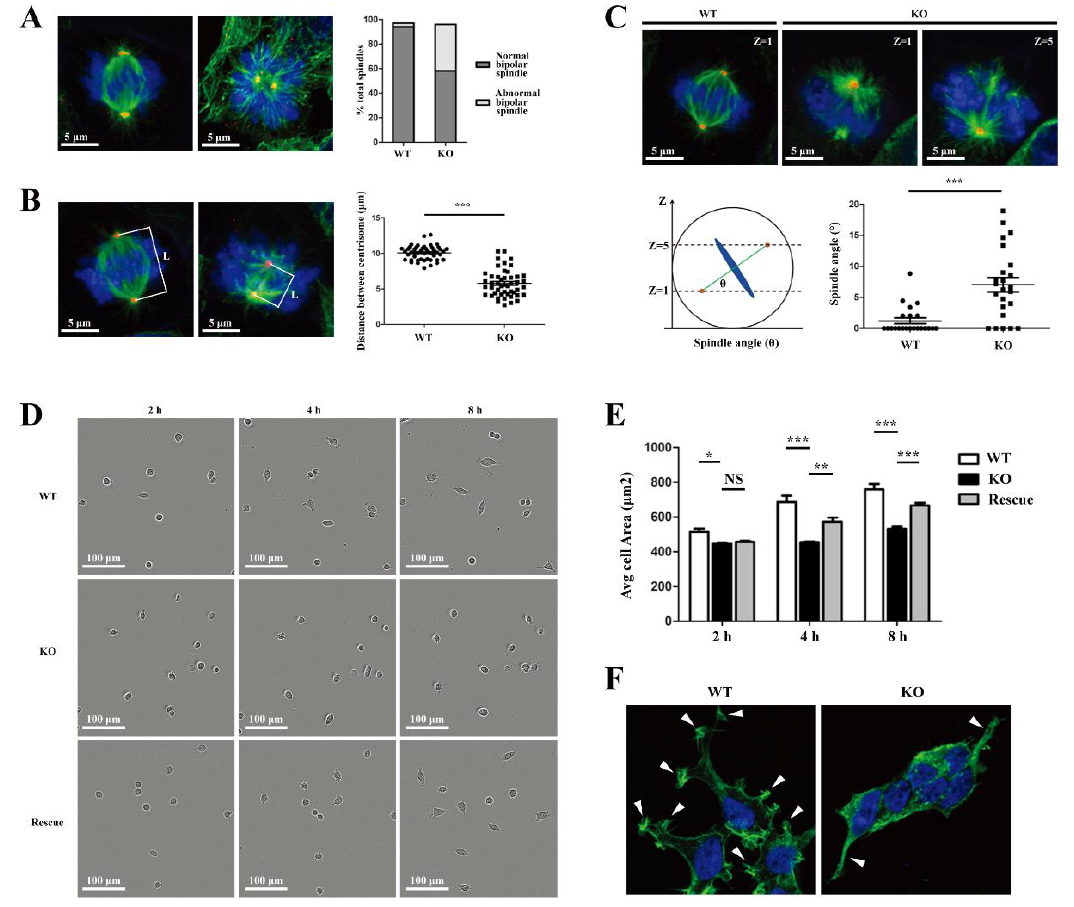
Figure 2. WDR73 KO causes uncontrolled spindle orientation and inhibits cell adhesion and spreading in cells. ( A ) WDR73 KO led to abnormal bipolar spindle formation. Immunofluorescence of mitotic spindles in WT and WDR73 KO cells with α -tubulin (green), γ -tubulin (red), and DNA (blue), Scale bar, 5 µ m. The percentage of abnormal bipolar spindles was calculated. n > 100 cells from three independent experiments. ( B ) Spindle length was reduced in WDR73 KO cells. Left: maximum projections of WT and WDR73 KO cells stained for α -tubulin (green), γ -tubulin (red), and DNA (blue), L: distance between centrosome.Right: interpolar distances measured on single-plane confocal images. n > 100 cells from three independent experiments. *** p < 0.001 ( t -test). Error bars represent mean ± SEM. ( C ) Uncontrolled spindle orientation in WDR73 KO cells. Left: immunofluorescence of the mitotic spindles in WT and WDR73 KO cells with α -tubulin (green), γ -tubulin (red), and DNA (blue). Representative images of z sections (0.299 um per stack) with maximum centrosome intensity in metaphase cells are shown. Scale bar: 5 µ m. Middle: diagram of mitotic spindle angle calculated by 1/tan (the distance between centrosomes along the z axis/the distance between centrosomes in the xy plane). Right: The spindle angle was significantly increased in WDR73 KO cells (WT, n = 22; WDR73 KO, n = 24, *** p < 0.001 ( t -test); error bars represent mean ± SEM). ( D , E ) Delayed adhesion and spreading in WDR73 KO cells. WT, WDR73 KO, and rescued cells were plated and monitored by IncuCyte. The images and average cell areas at 2, 4, and 8 h points are shown. n > 100 cells from three independent experiments. * p < 0.05, ** p < 0.01 and *** p < 0.001 ( t -test). Error bars represent mean ± SEM. Scale bar: 100 µ m. ( F ) Pseudopodia decreased in WDR73 KO cells. At 48 h after cell plating, microfilament was labeled with 488-phalloidin. White arrow: pseudopodia. Experiments were repeated three times. Scale bar: 20 µ m. NS: not